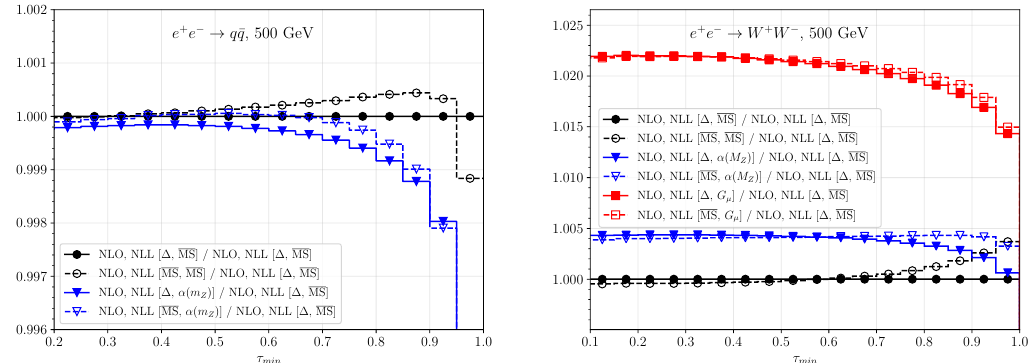
Figure 5 . Ratios of cross sections computed with NLL PDFs for all possible combinations of renormalisation and factorisation schemes, over those computed with NLL- ∆ PDFs in the MS renormalisation scheme. Left panel: q ¯ q production; right panel: W + W − production.